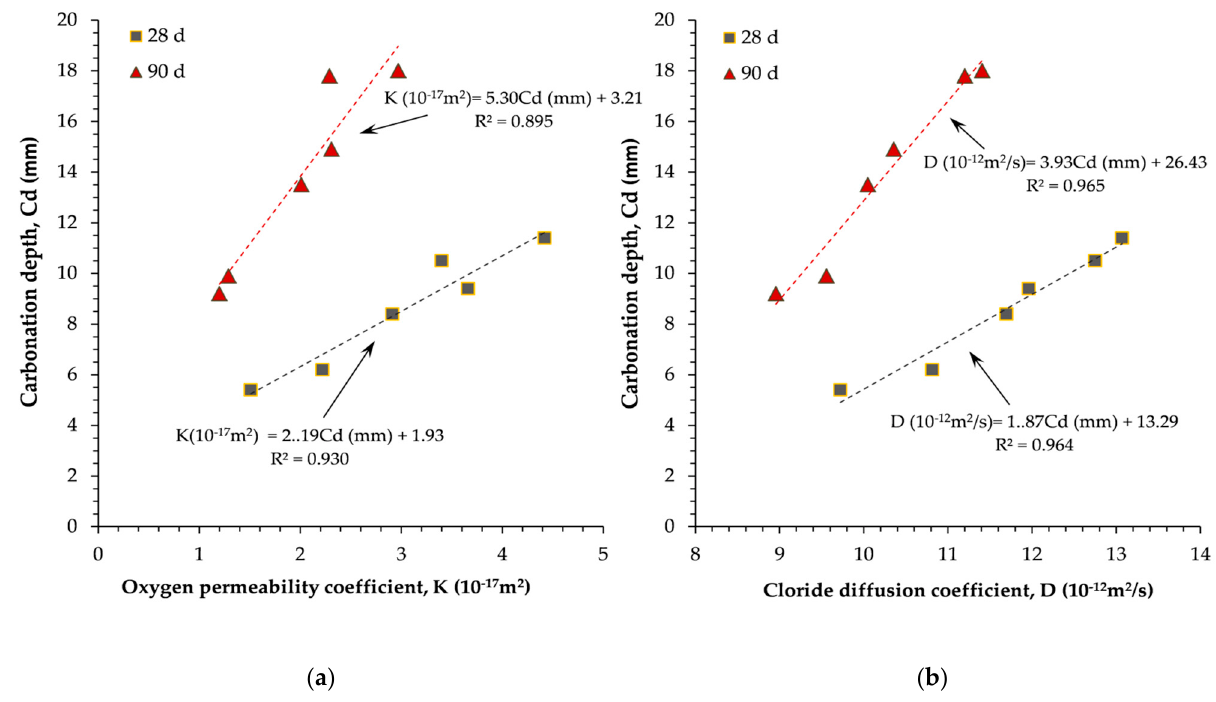
Figure 5. Relationship in 28 d and 90 d mixes between ( a ) carbonation and oxygen permeability coefficient; and ( b ) carbonation and chloride diffusion coefficient.